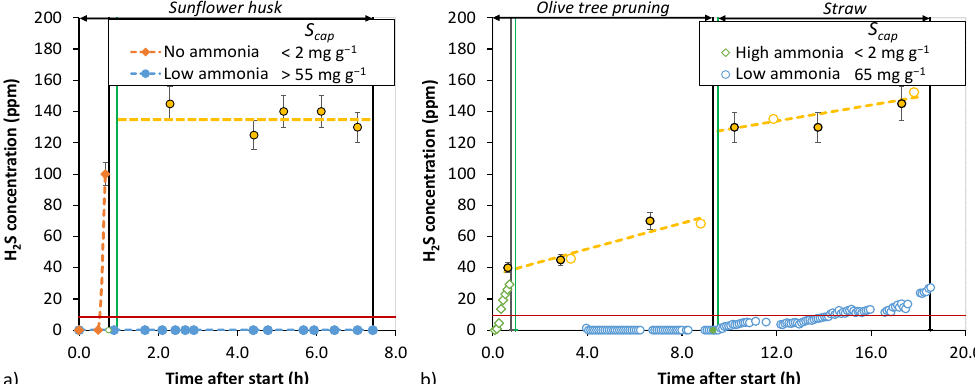
Figure 8. High space velocity (~15,500–17,500 h −1 ) bench-scale H 2 S breakthrough experiments. ( a ) One day campaign with adsorbent AC2 with sunflower husk-based syngas. Syngas feed H 2 S content rate—125–150 ppm. ( b ) Two-day campaign with adsorbent AC1 in olive tree pruning- and straw-based syngas. Particle size distribution—1.0–1.25 mm. Vertical green lines indicate start, and black lines indicate the end of the experiment. Experiments were performed at atmospheric pressure and 16–18 °C temperature. Hollow markers: GC analysis; filled markers: Dräger analysis. Yellow dashed line indicates estimated feed H 2 S concentration.